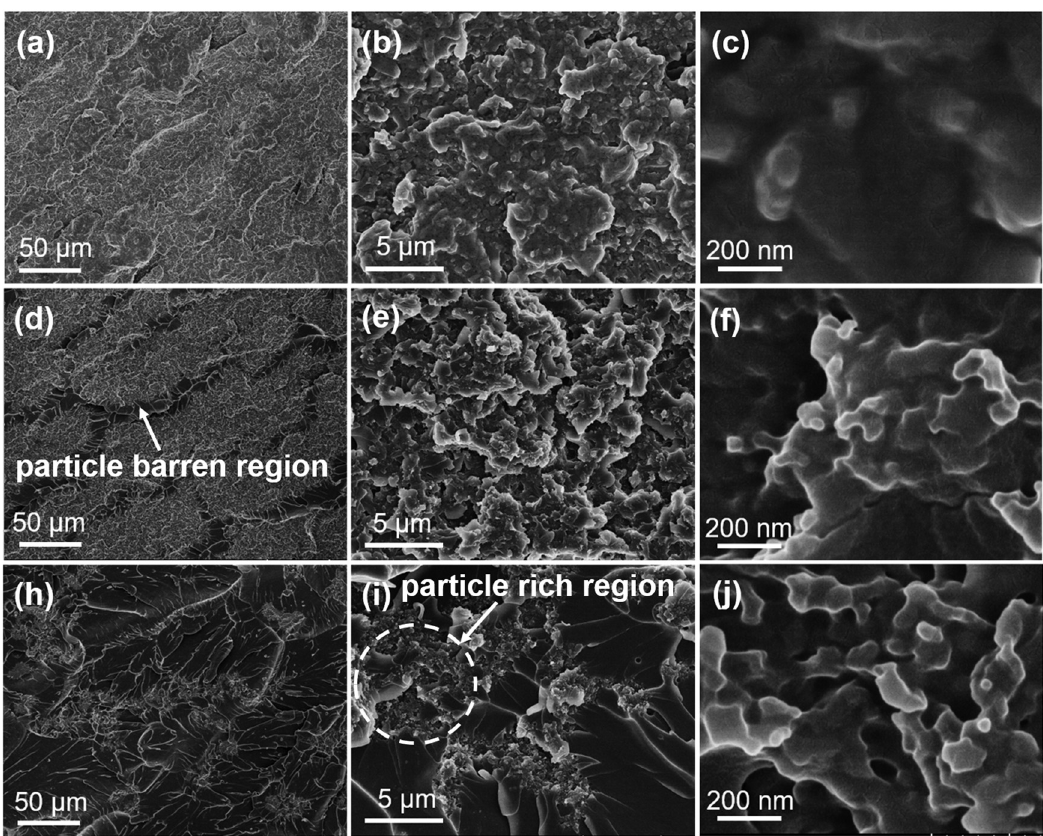
Figure 7: SEM micrographs of fracture surfaces of cured epoxy resins containing particles: ( a – c ) B/M, ( d – f ) B/S and ( h – j ) B/A with the particle - rich region in the focus